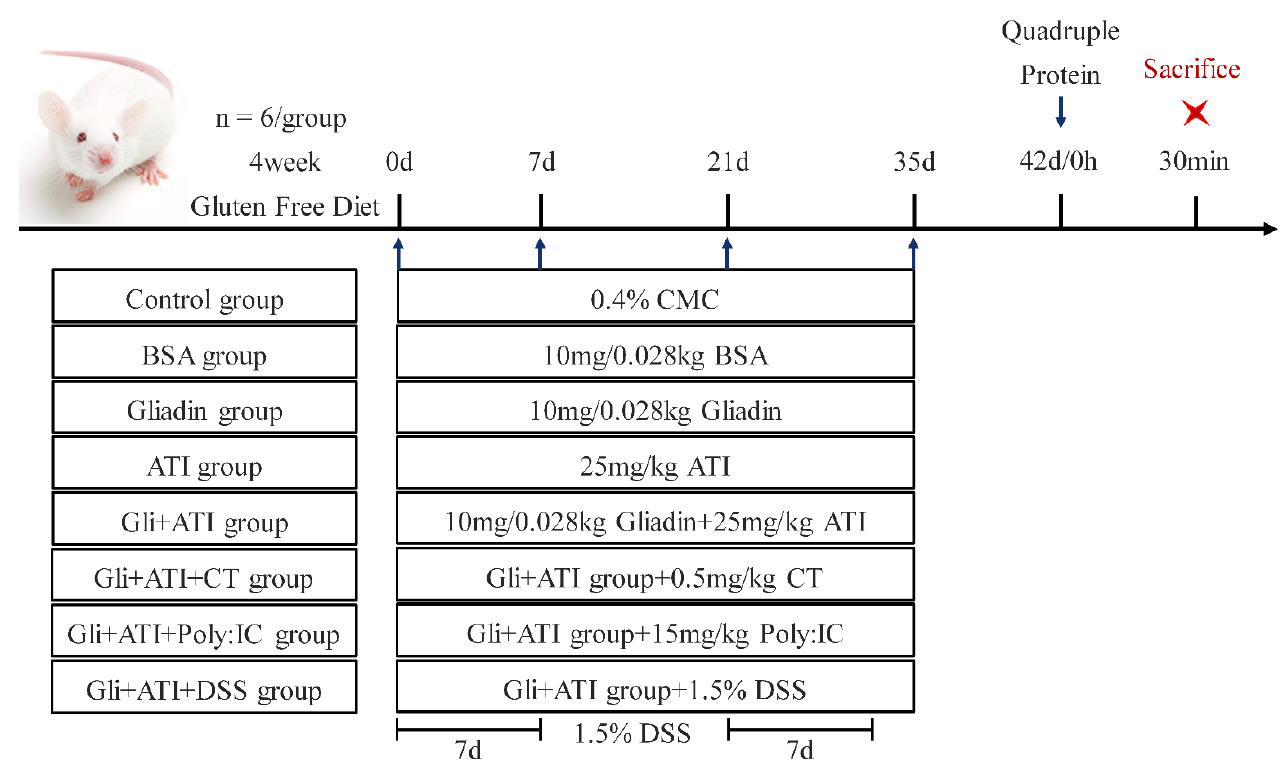
Figure 1. Timeline of experimental protocol.